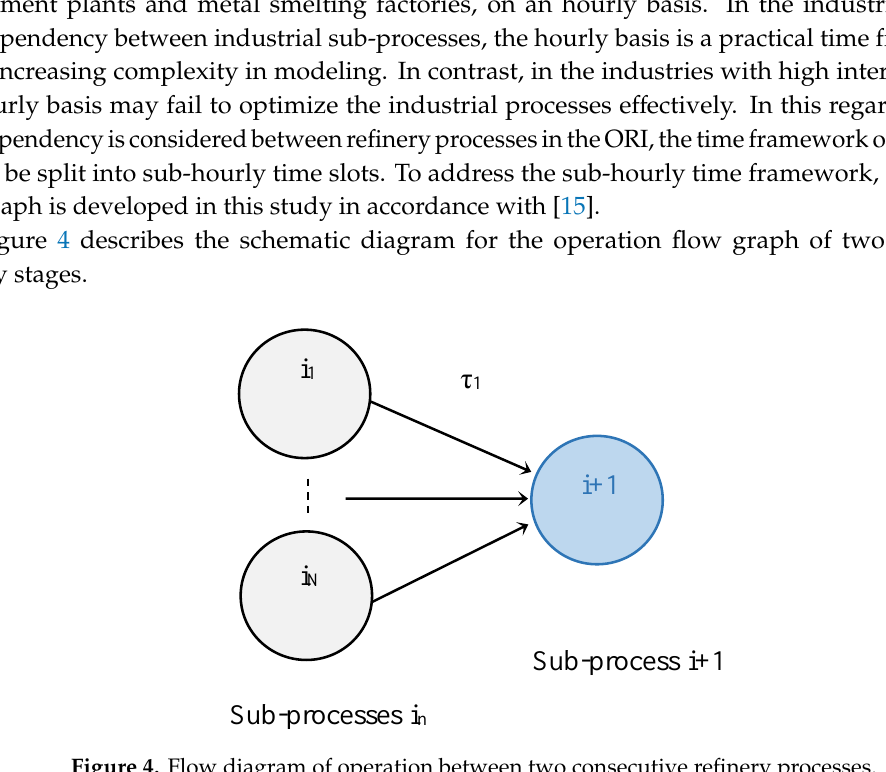
Figure 4. Flow diagram of operation between two consecutive refinery processes.